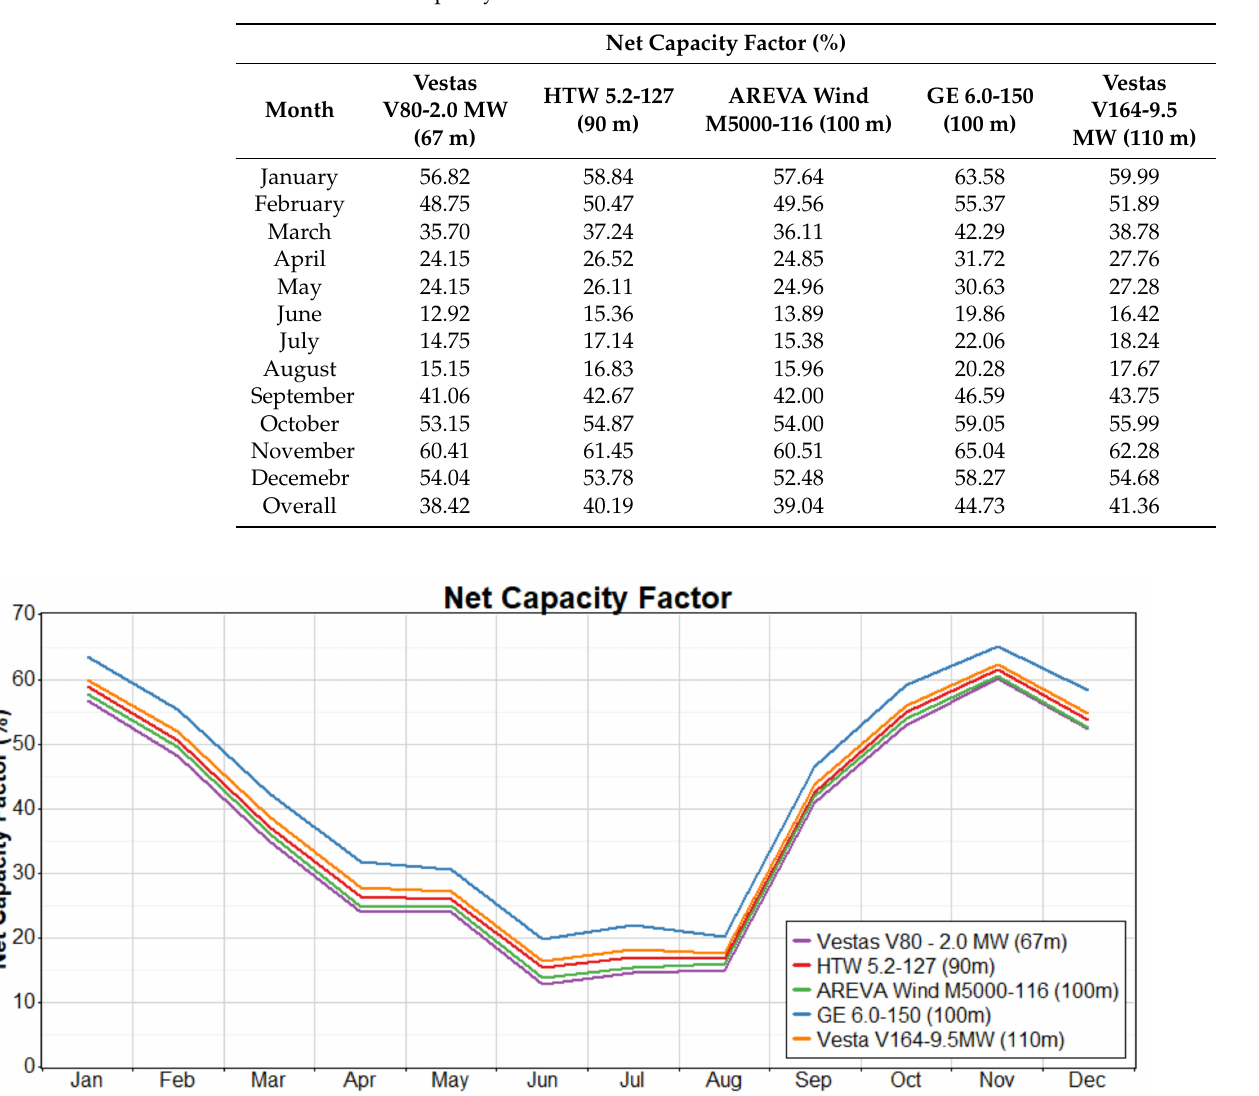
Table 3. 2019 Net capacity factors for five wind turbines.